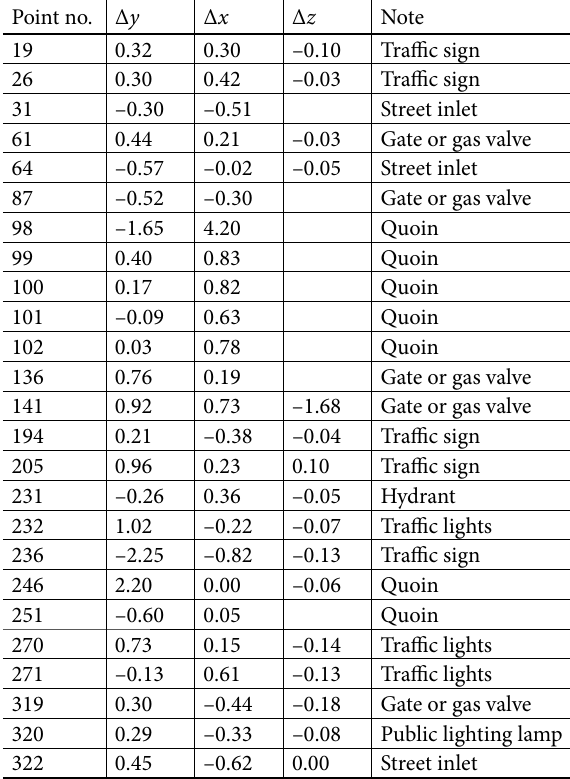
Table 3. Points with positional deviation u p > 2 u xy in Přívoz cad.